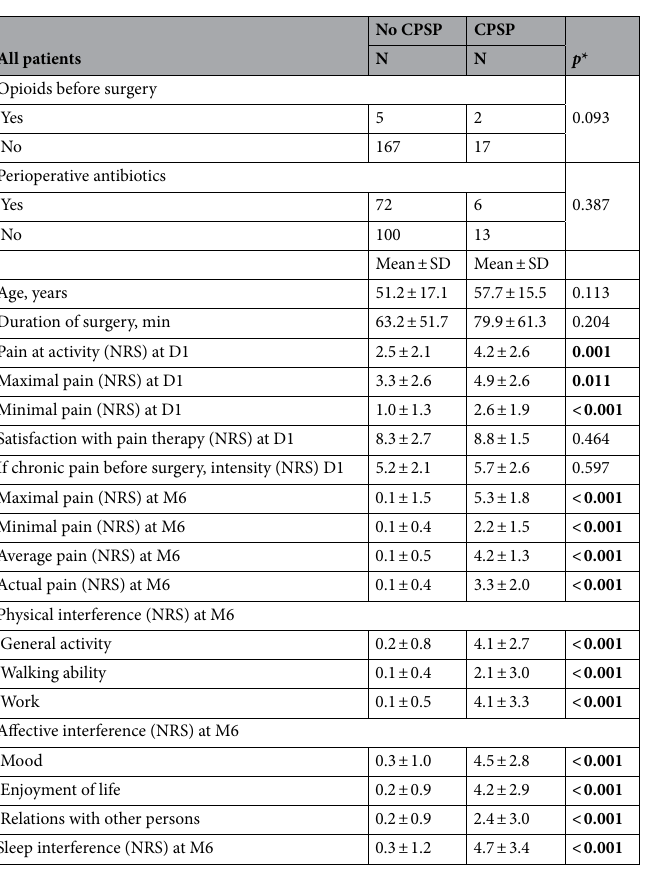
Table 1. Comparison of the characteristics of patients without chronic postsurgical pain (CPSP) or with CPSP 6 months (M6) after otorhinolaryngological (ORL) surgery. NRS = numeric rating scale; OPS = Operation and Procedure Code. *Pearson’s chi-square test or Fisher’s exact test was used to compare ordinal and nominal data of patients without CPSP and with CPSP. The nonparametric Mann–Whitney-U-test was used to compare metric data. Bold values are statistically significant for p <